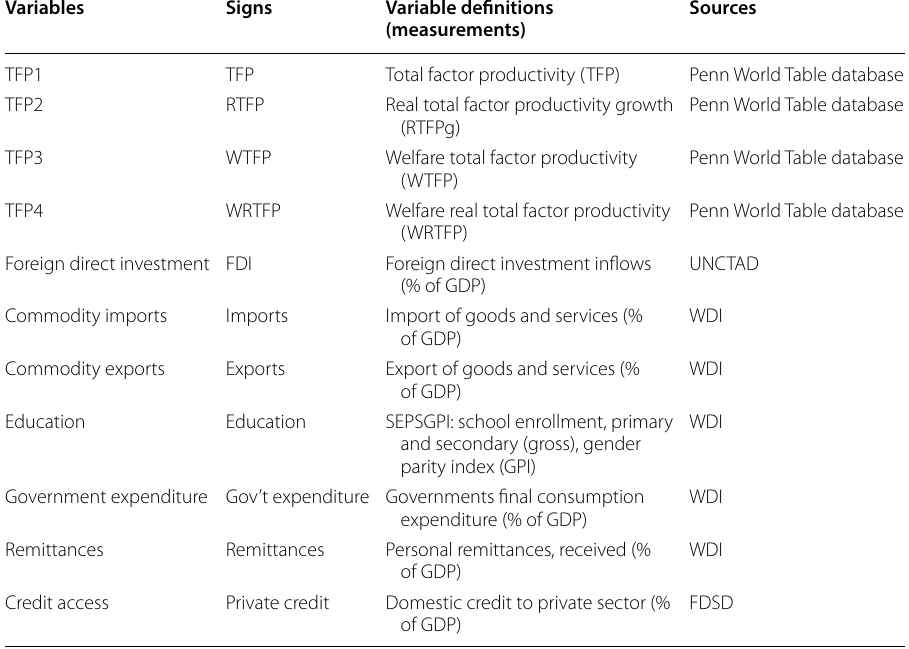
WDI World Development Indicators, GDP Gross Domestic Product, UNCTAD United Nations Conference on Trade and Development, FDSD Financial Development and Structure